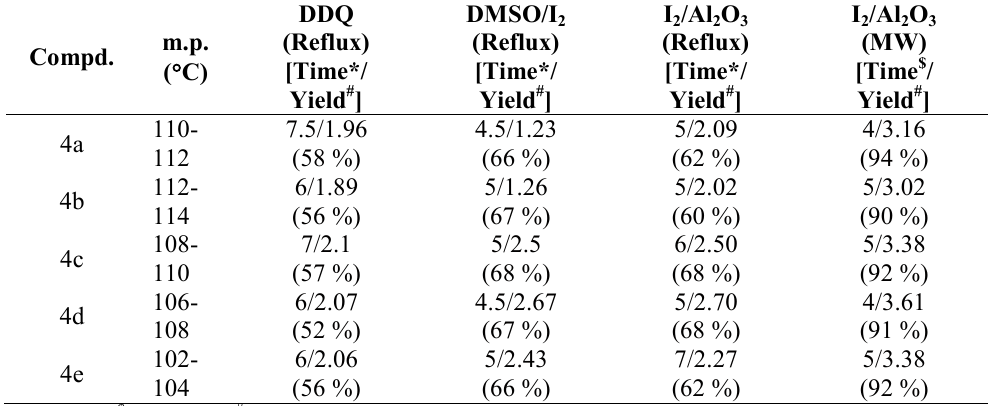
Table 1. Physical Data of Flavone derivatives,